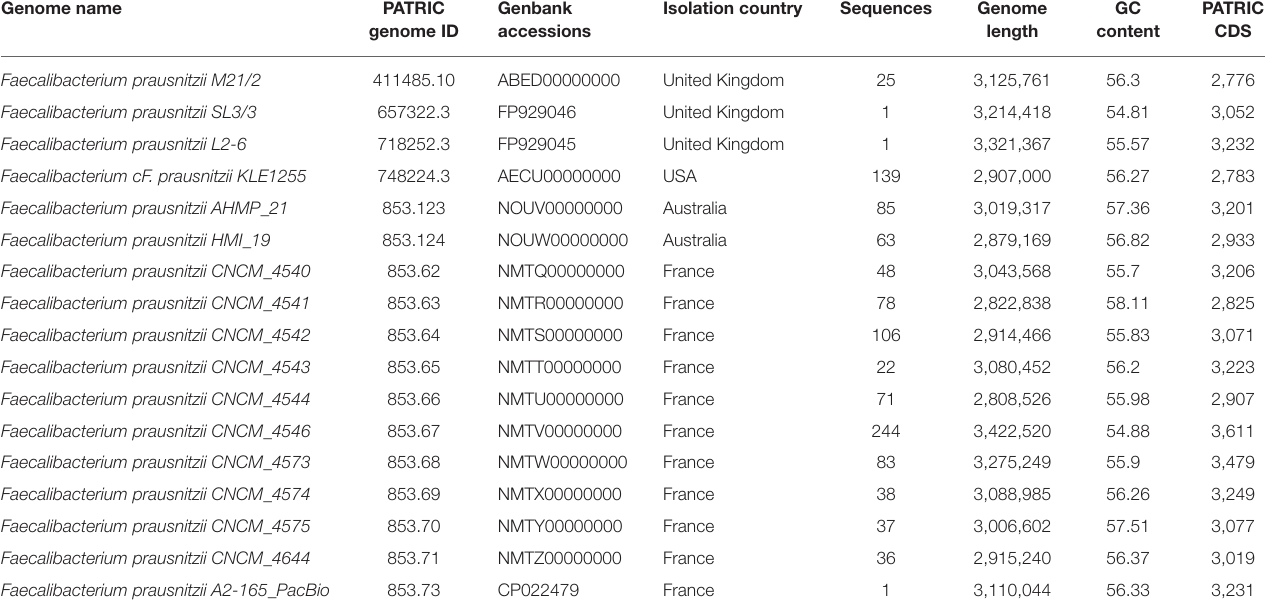
TABLE 1 | Genomic features of F. prausnitzii